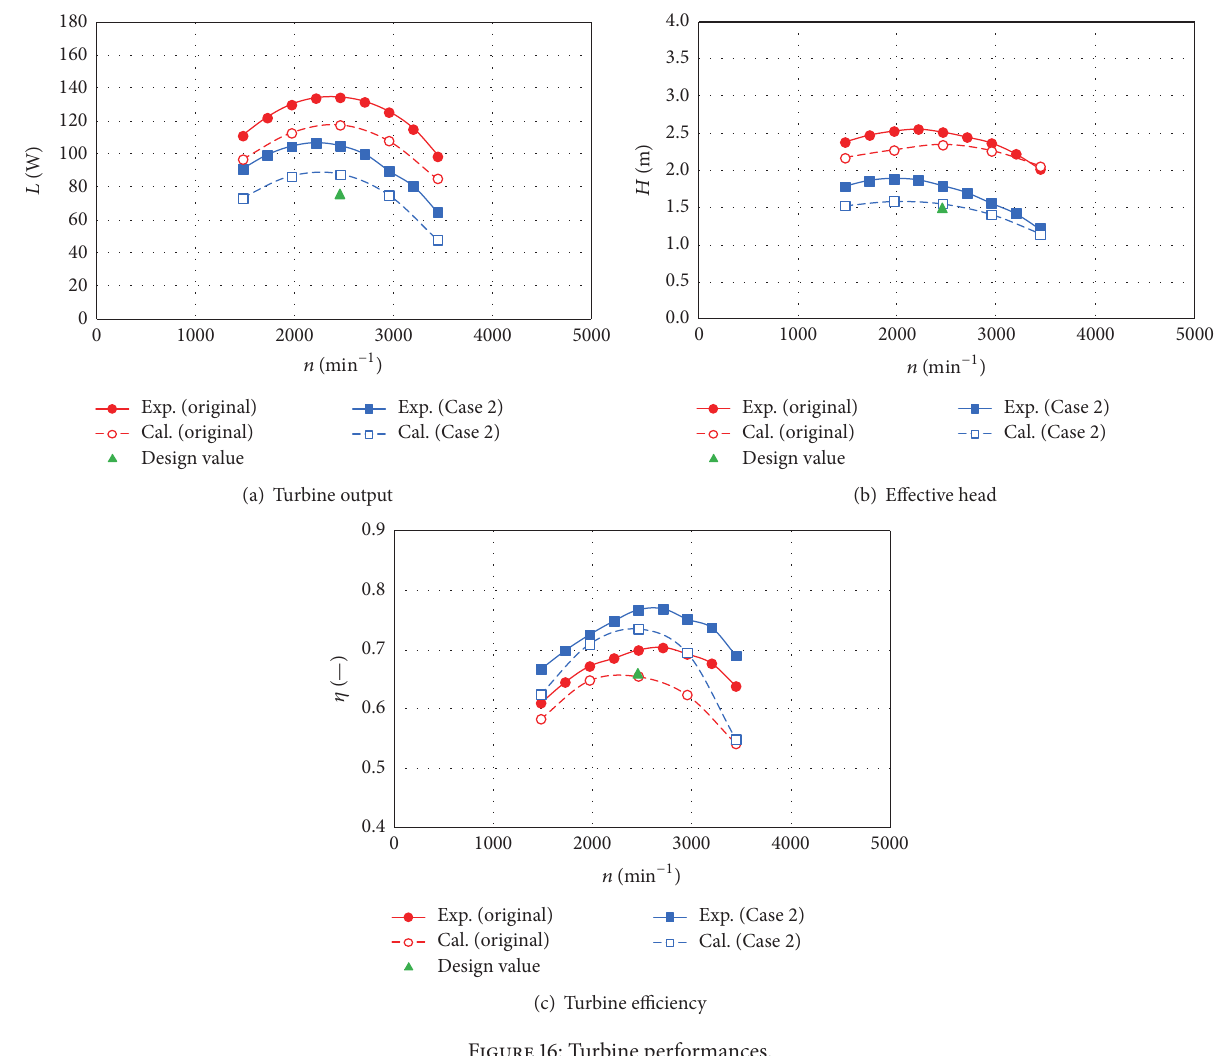
Figure 16: Turbine